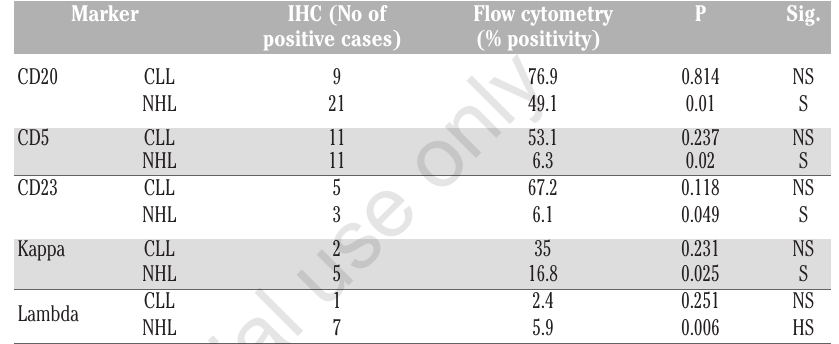
Table 2. Comparing percent positivity of immunohistochemistry and flow cytometry in chronic lymphocytic leukemia and non Hodgkin lymphoma groups. Marker IHC (No of